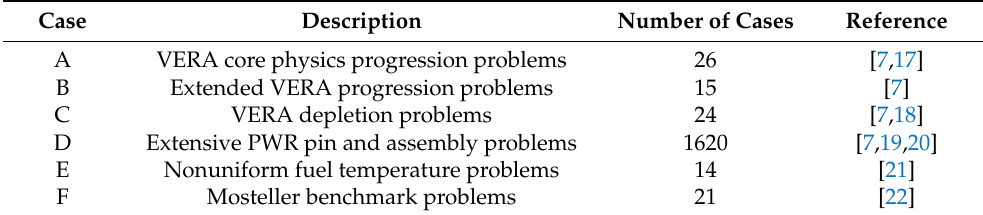
Table 1. The PWR benchmark